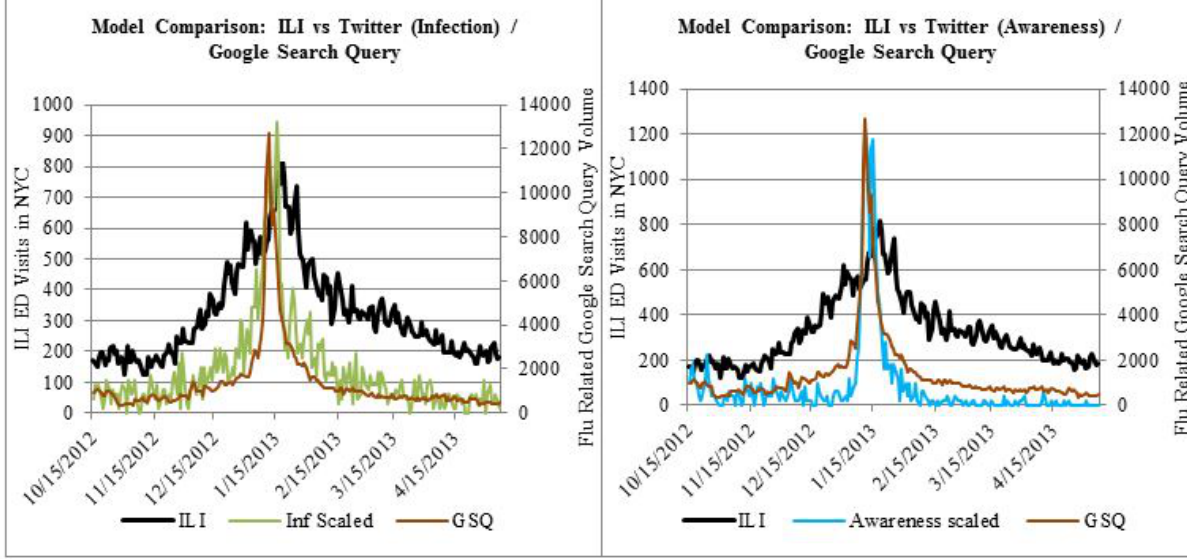
Linear Regression Models